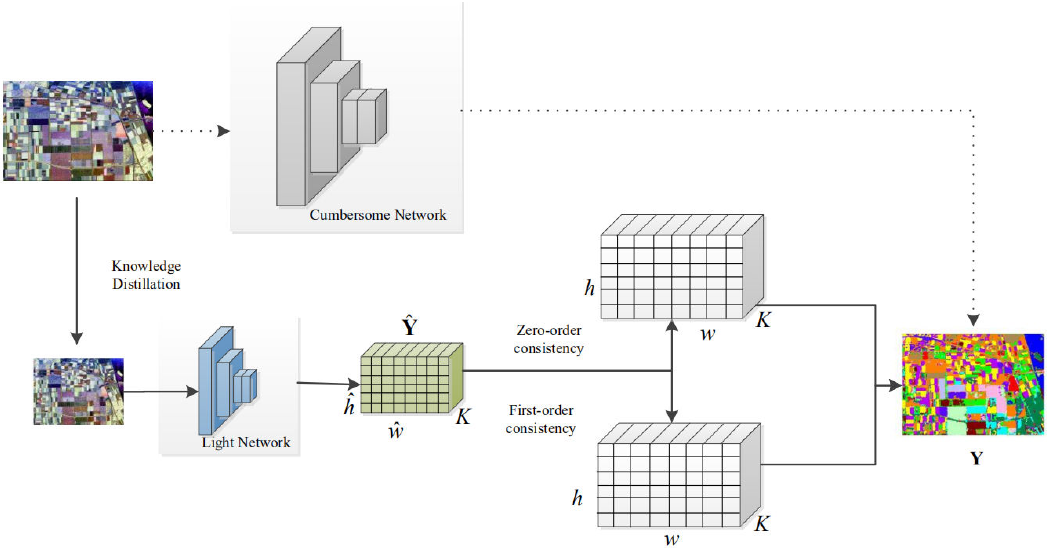
Figure 2. Illustration of entire proposed framework (dashed line is used to explain the conciseness of the light network without being used in the